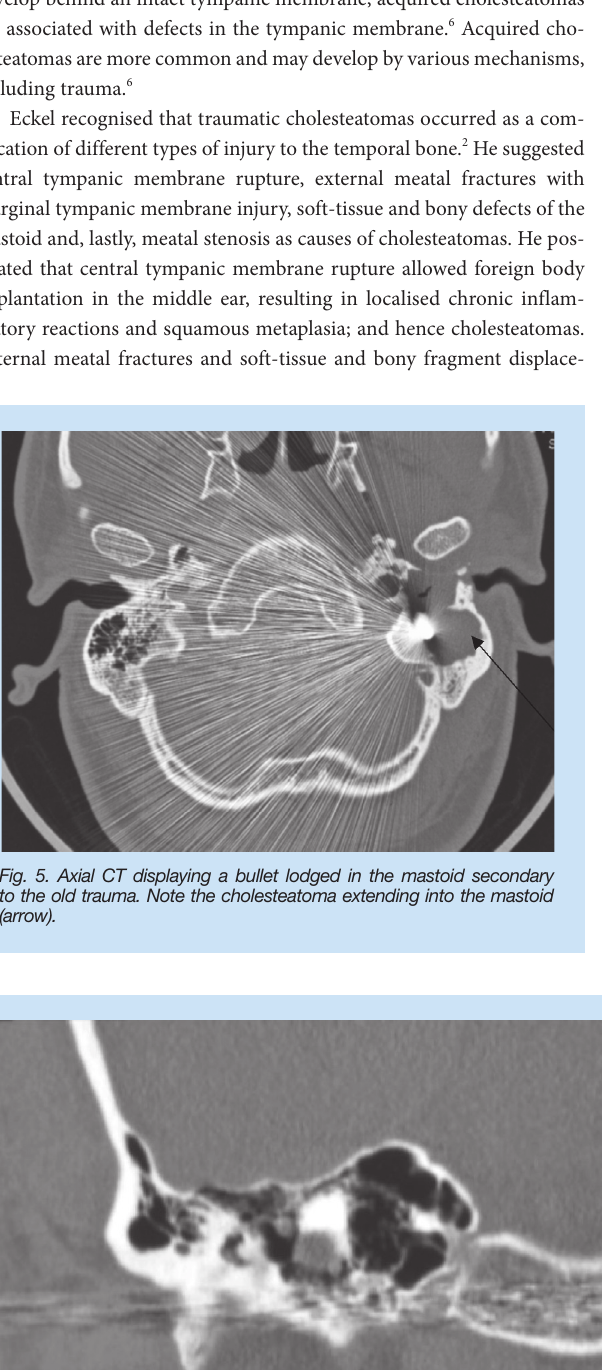
Post-traumatic.indd